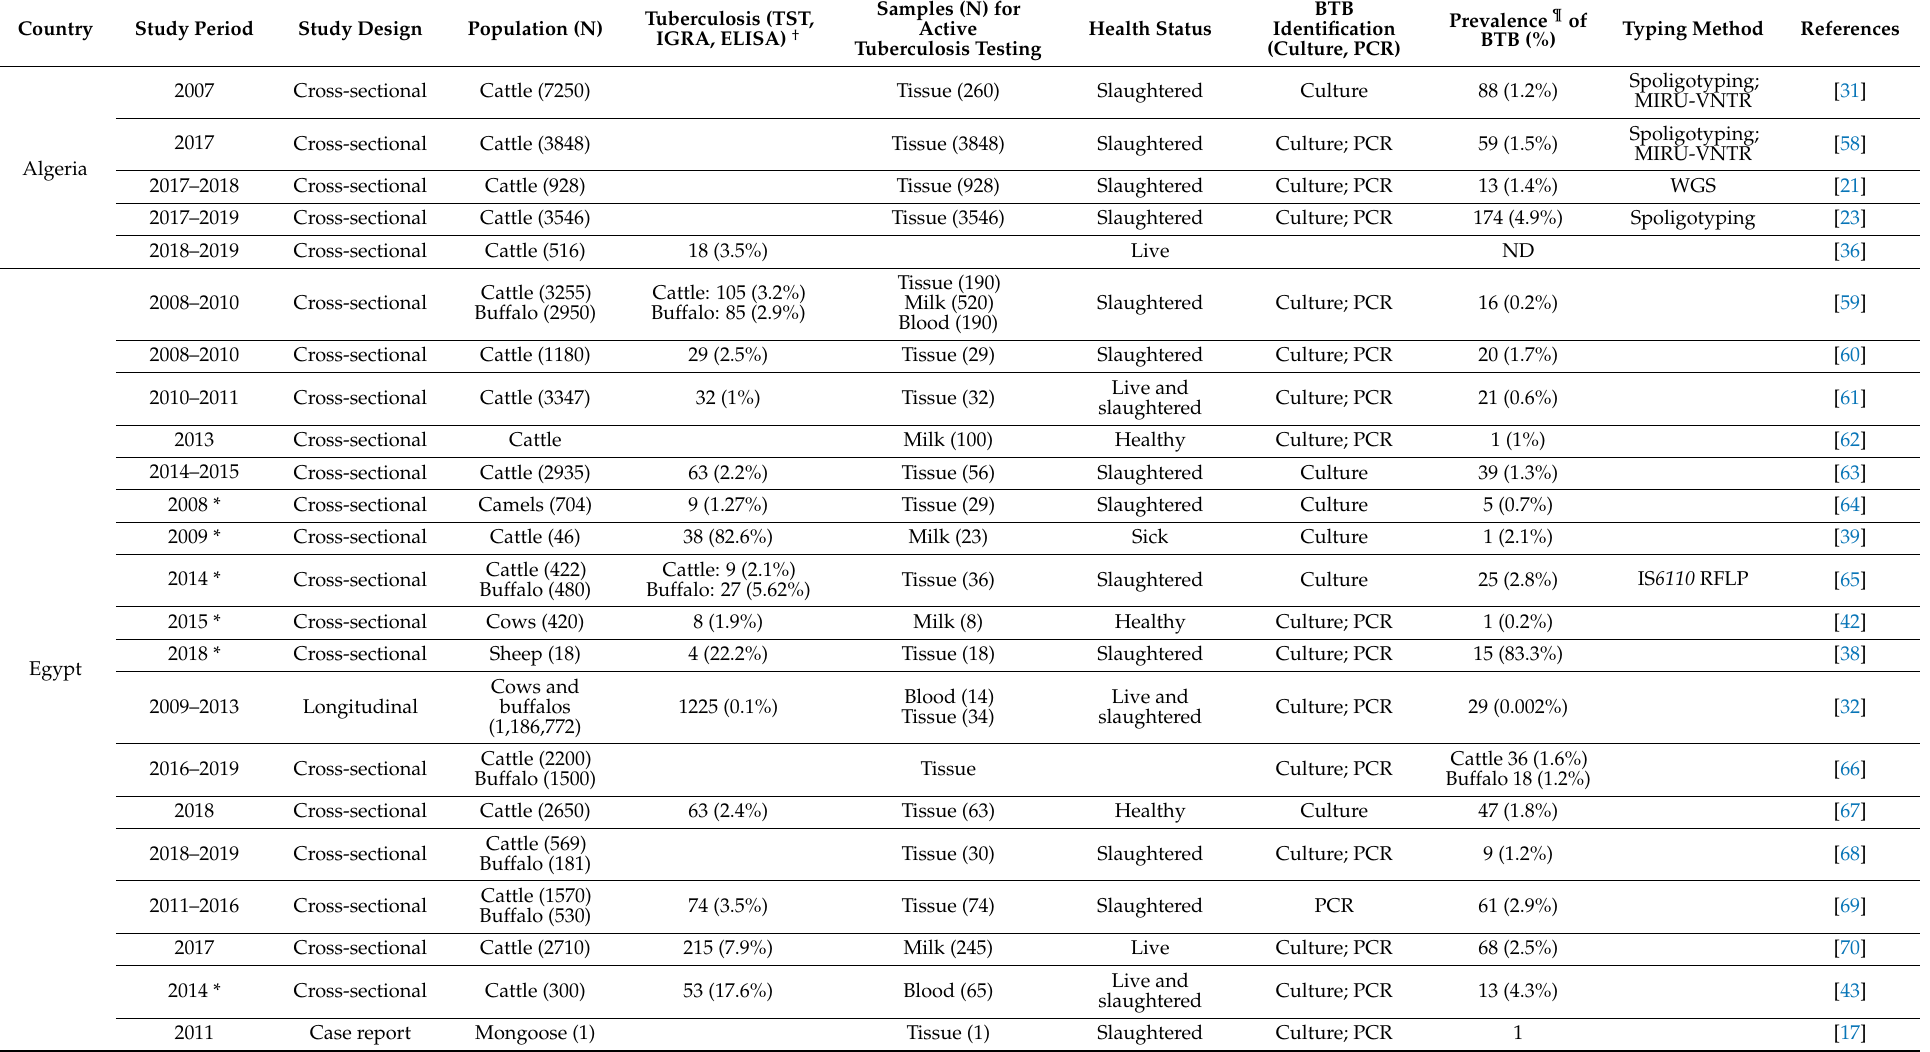
Table 1. Burden of Mycobacterium bovis in animals in the MENA